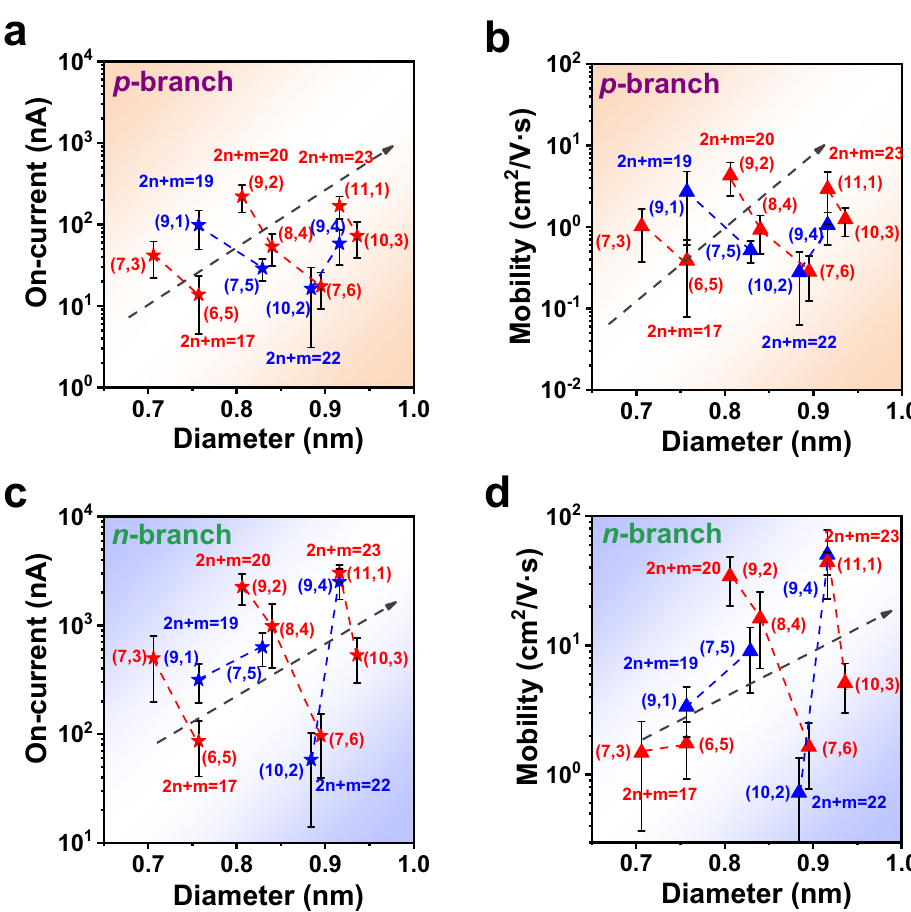
Fig. 3 | On-state currents and mobility of the transistors constructed by dif- ferent single-chirality SWCNT fi lms as a function of their diameter. a , c Statistical distribution of the on-state current; ( b , d ) statistical distribution of themobility;( a , b )electricalfeaturesofthe p -branch,( c , d )electricalfeaturesofthe